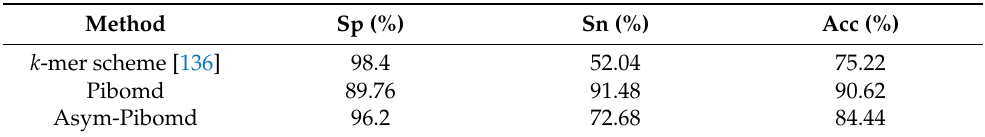
Table 1. Comparison of the performance of the imbalance and balanced SVM classifier of Pibomd with the k -mer